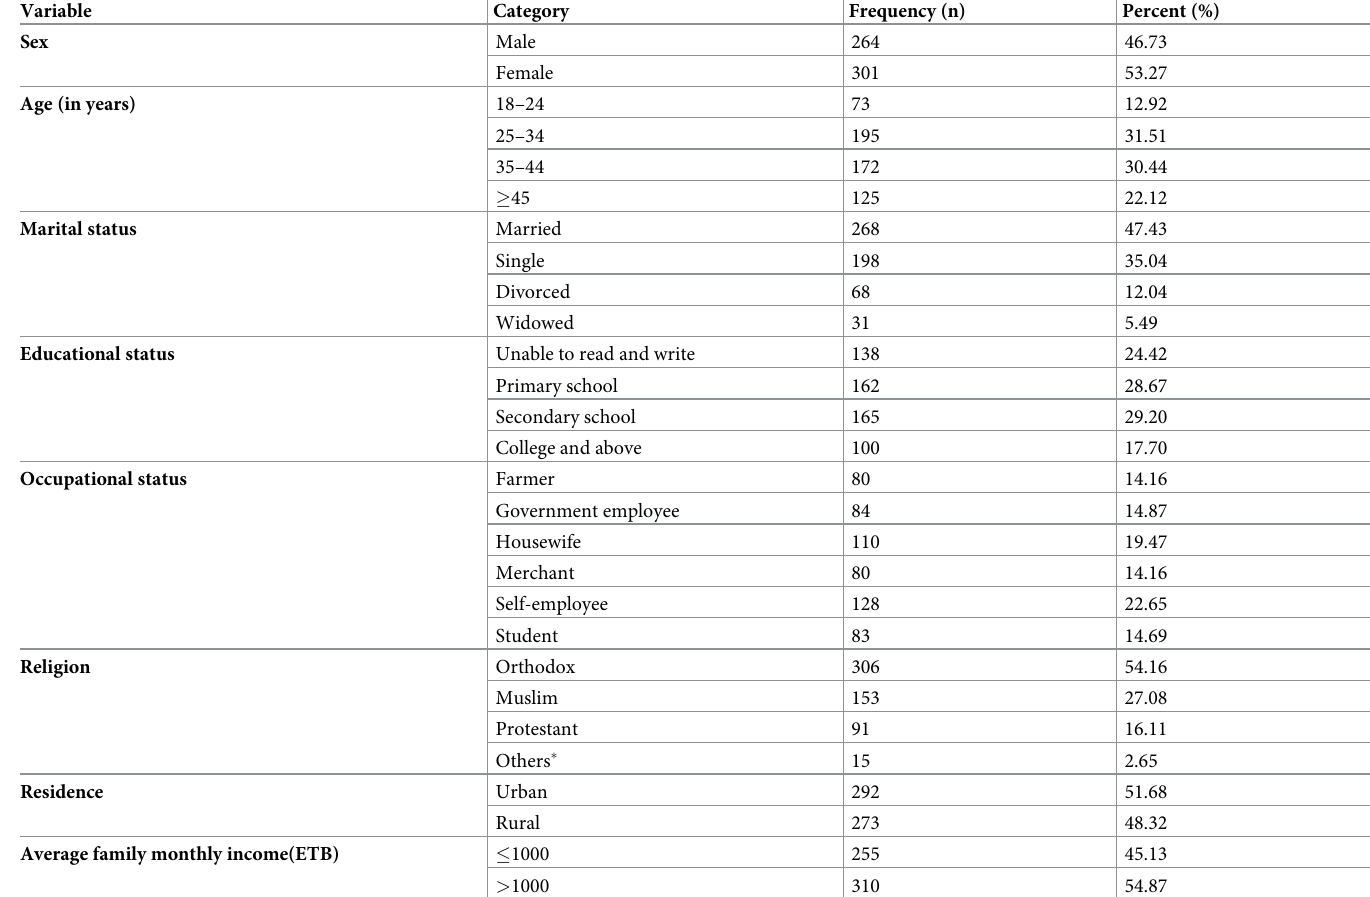
Table 1. Socio-demographic characteristics of adult patients with epilepsy attending follow-up care at referral hospitals in Amhara region, Ethiopia, 2021 (n =